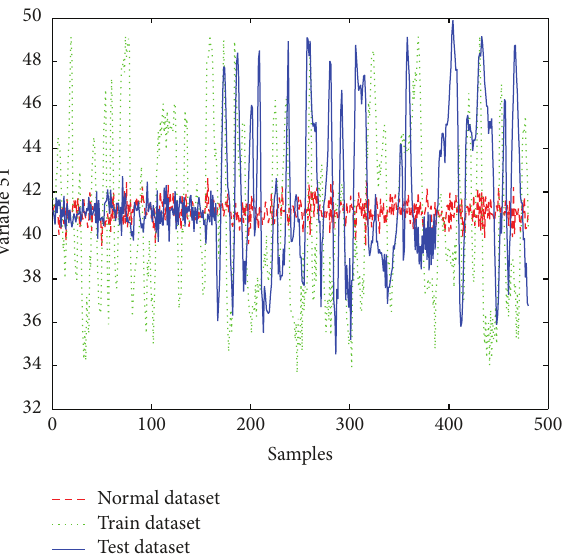
Figure 9: TE: plot of variable 51 in fault 11.